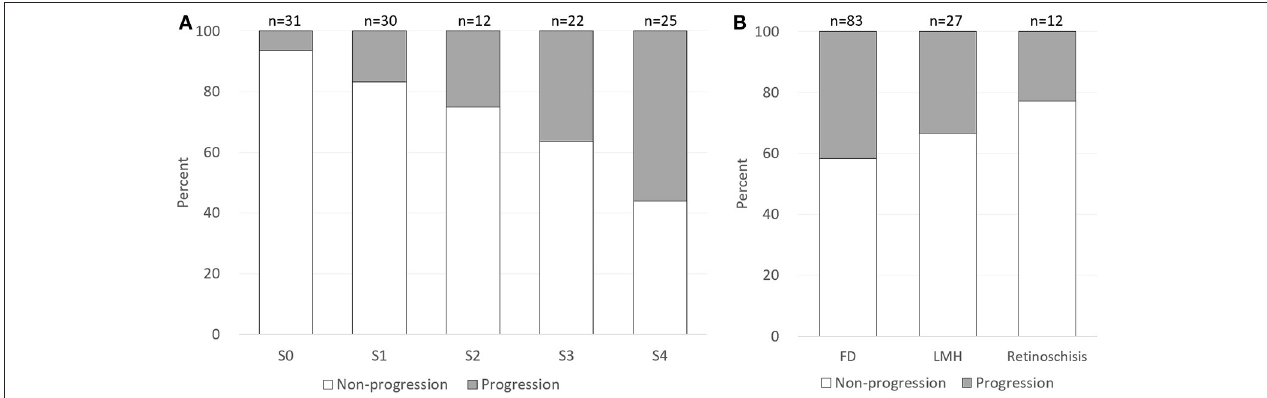
FIGURE 2 | Proportion of myopic tractional maculopathy progression by category of retinoschisis and foveal complications at baseline. (A) The progression rate increased with the increasing severity of retinoschisis (S0–S4). (B) Eyes with foveal detachment showed the highest progression rate (41.67%), followed by the eyes with lamellar macular hole (33.33%) and the eyes with isolated retinoschisis (22.89%). FD, foveal detachment; LMH, lamellar macular hole.